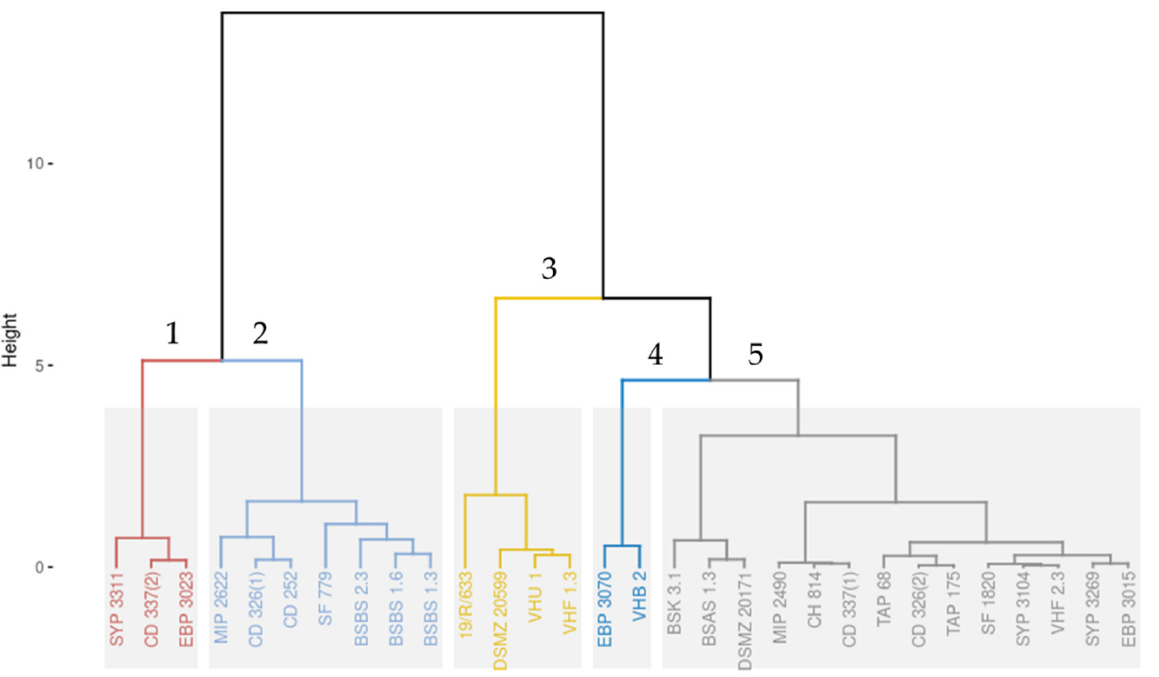
Figure 3. Hierarchical clustering on principal components (HCPC) dendrogram. Principal com- ponents were defined using principal component analysis (PCA) on the 74 BiofilmQ parameters extracted from confocal laser scanning microscopy (CLSM) images. Five clusters were identified based on the automatic cut tree of HCPC tool. Those clusters were numerated and colored as 1—red, 2—light blue, 3—yellow, 4—dark blue, and 5—grey.